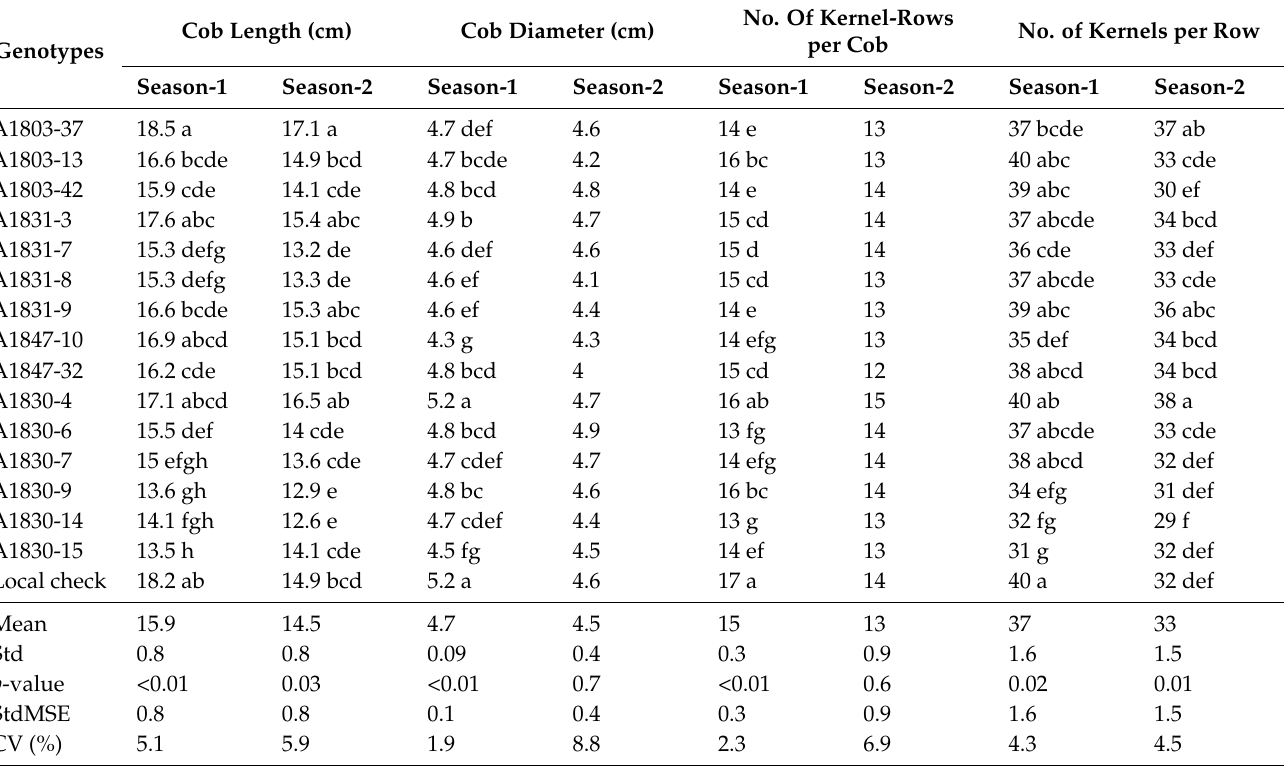
Table 7. Cob characteristics recorded in zinc biofortified maize genotypes from the two contrasting seasons.